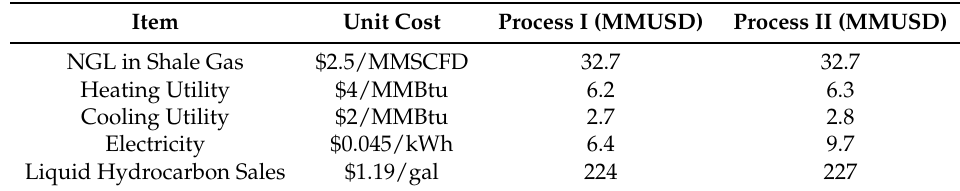
Table 5. Key economic parameters and operating costs for Process I and II. MMSCFD: million standard cubic feet per day.